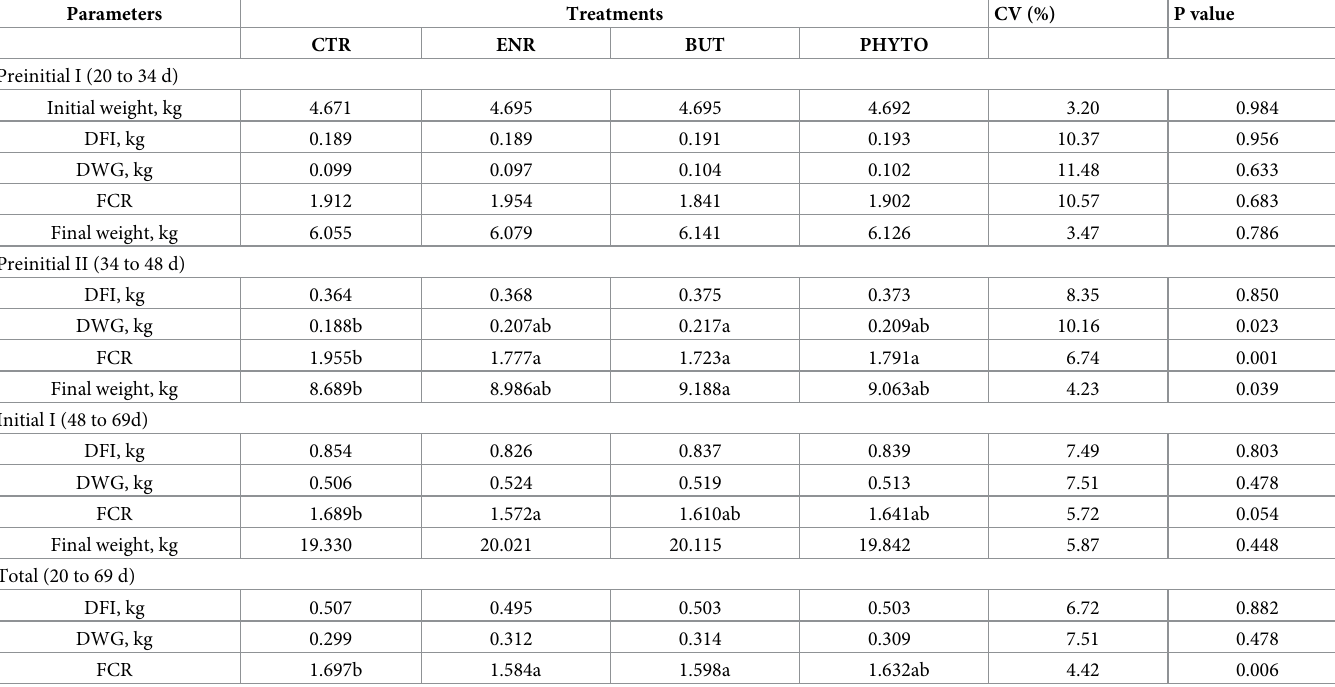
Table 3. The effects of feed supplementation with enramycin (ENR), encapsulated sodium butyrate (BUT) and dry herbs plus essential oils (PHYT) on the growth performance of lightly weaned piglets in the nursery phase (n = 50/treatment). Parameters